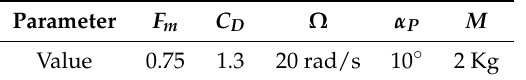
Table 2. General parameters for the power consumption field.